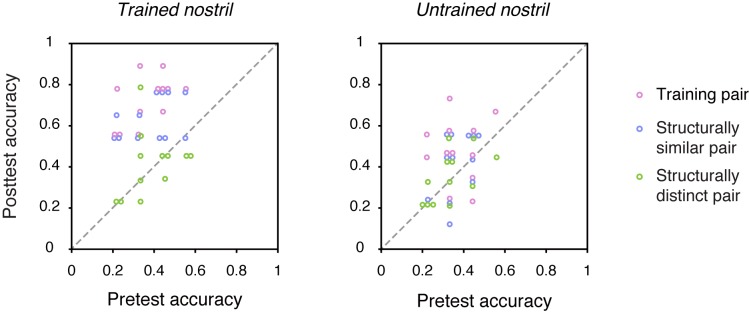
Chiral discrimination accuracies at pretest and posttest for each pair of odor enantiomers presented to the trained vs. untrained nostril for individual participants in Experiment 2.